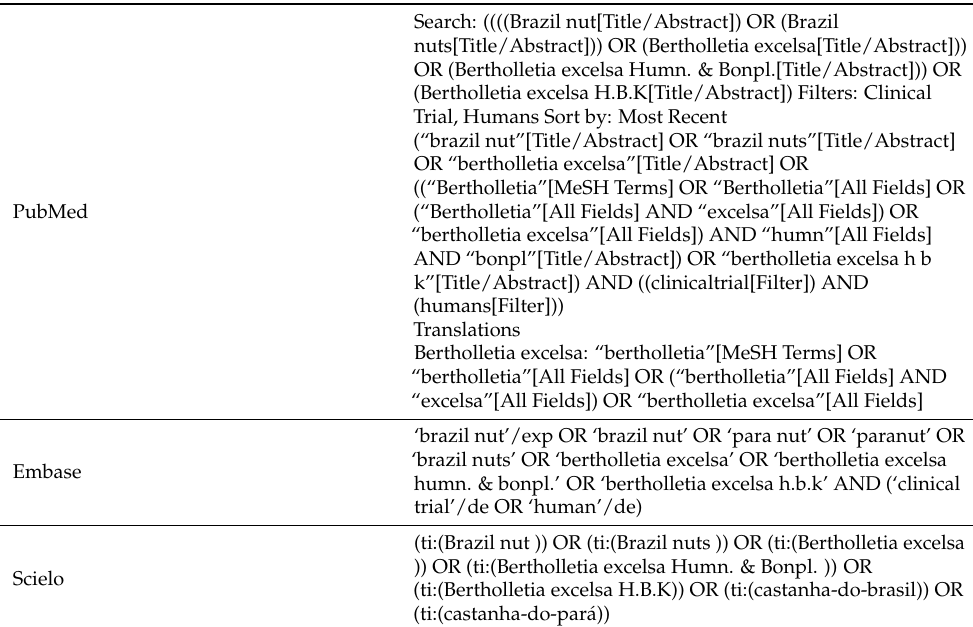
Table A1. Search strategy.